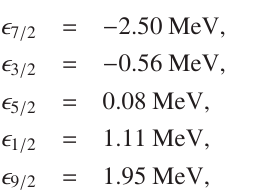
Figure 2. Level spacing distribution P ( S ) (left panel) and spec- tral rigidity ∆ 3 ( L ) (right panel) for the J = 0 levels in 48 Ca with G = 0 . 4385 MeV and for the J = 3 / 2 levels in 49 Ca with G = 0 . 44 MeV. P ( S ) and ∆ 3 ( L ) for 48 Ca are of the Poisson type, while those for 49 Ca are of the GOE type.